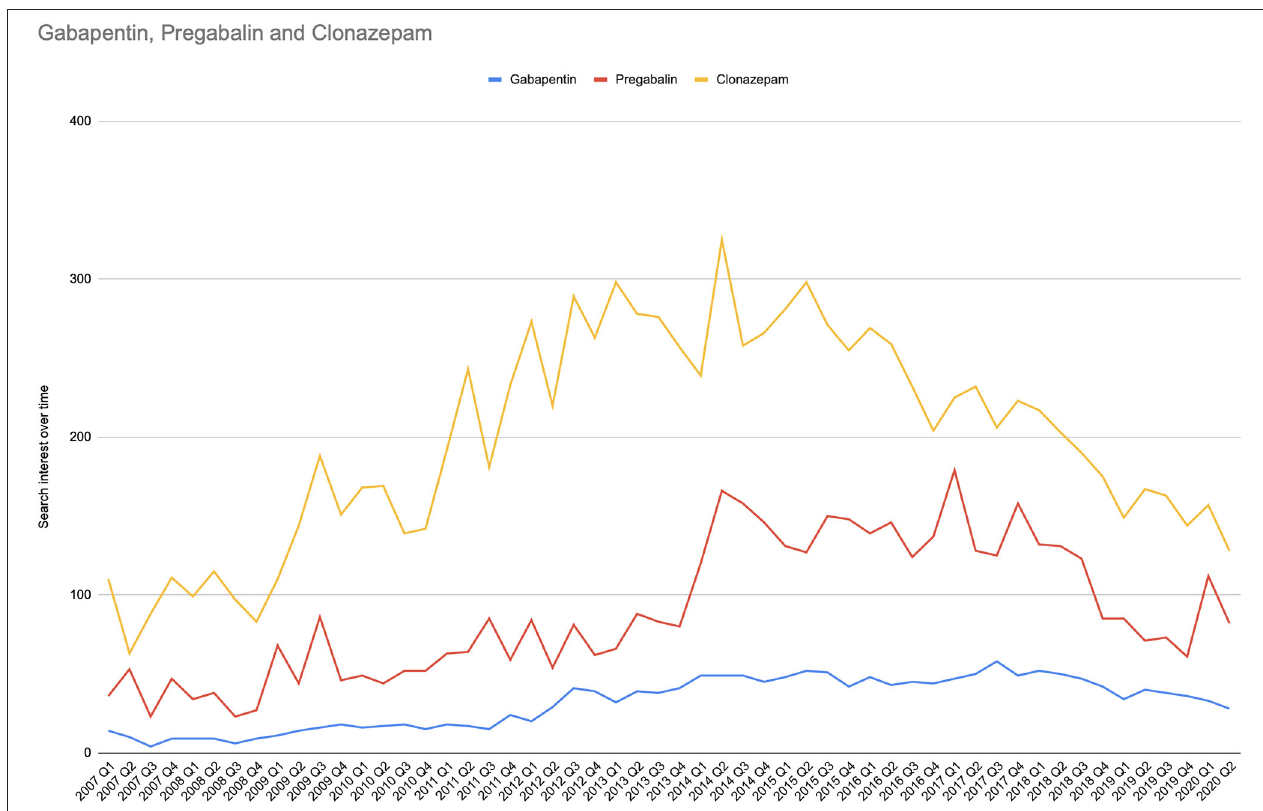
FIGURE 2 | Search interest over time for abuse-related terms in the search analytics domain. For the period 2007Q1 to 2020Q2, the search interest over time for abuse-related terms is represented in timelines for each drug and is expressed as quarterly relative search volume for overall abused-linked terms.